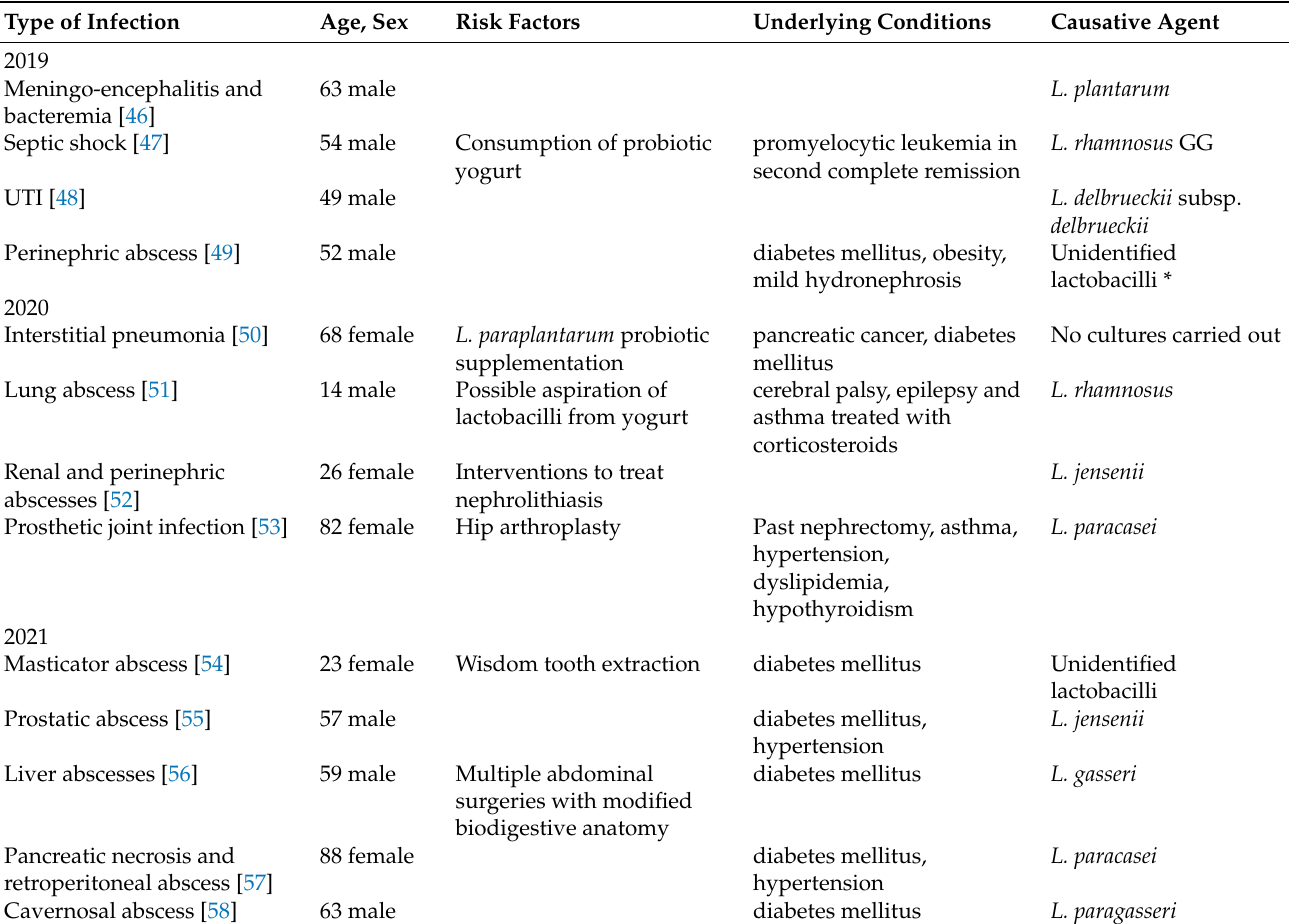
Table 2. Infections different from endocarditis and bacteremia caused by lactobacilli in years 2019, 2020, and